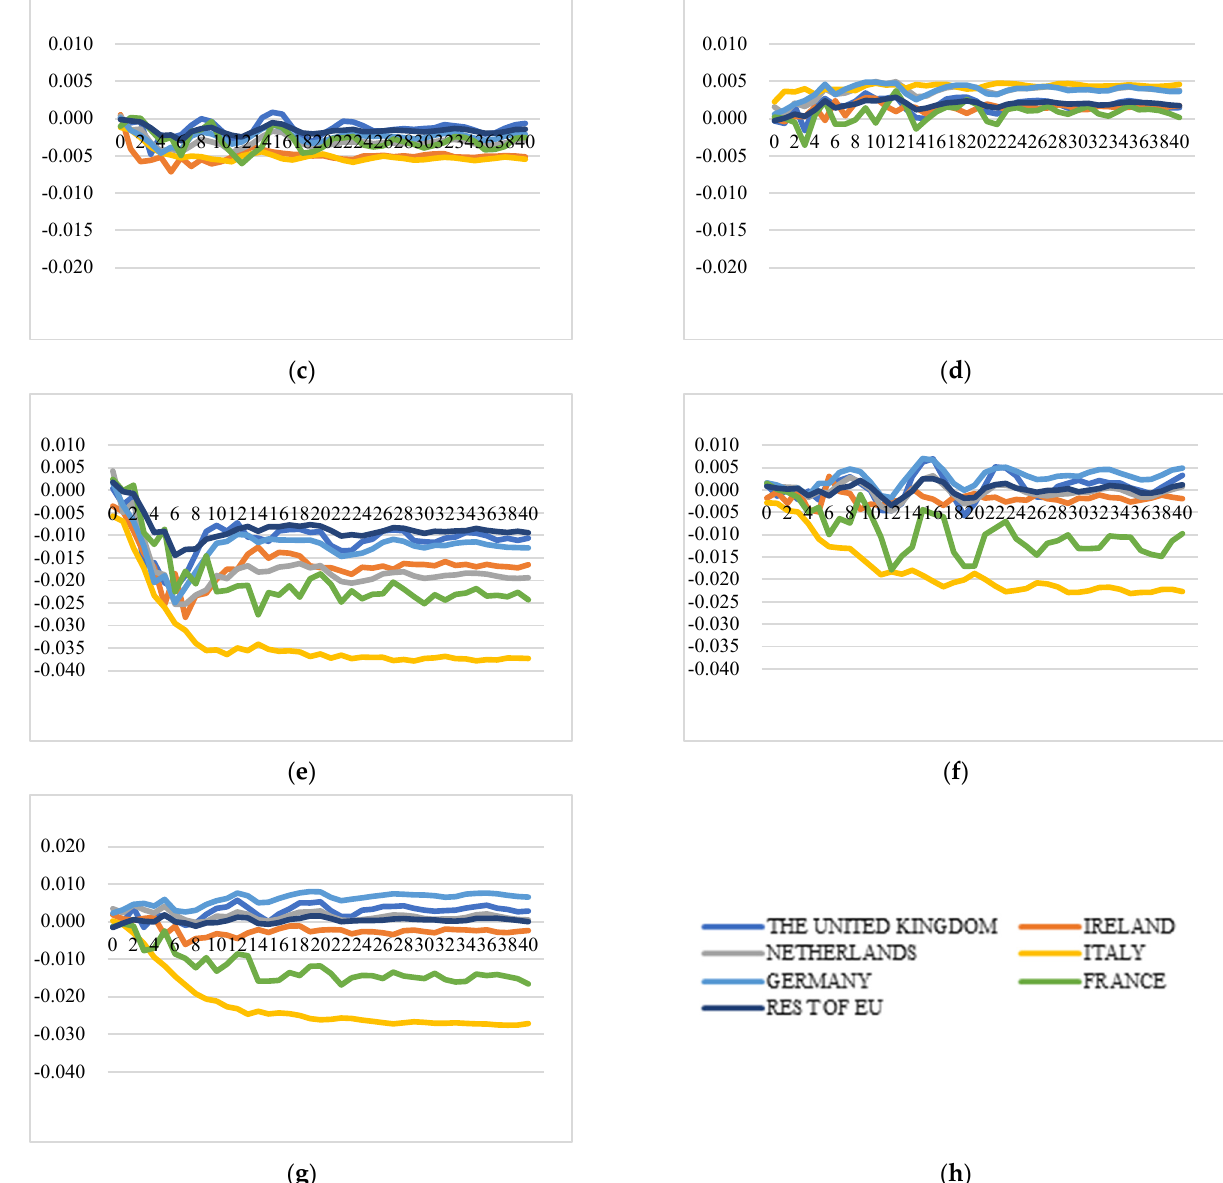
Figure 11. Generalized impulse response functions (GIRFs) of six EU member states’ intra-EU cheese export prices after a positive one-standard-error shock to the Harmonised Index of Consumer Price (HICP) of food (bootstrap median estimates). ( a ) GIRFs after a shock to France’s CPI. ( b ) GIRFs after a shock to Germany’s CPI. ( c ) GIRFs after a shock to Ireland’s CPI. ( d ) GIRFs after a shock to Italy’s CPI. ( e ) GIRFs after a shock to the Netherlands’ CPI. ( f ) GIRFs after a shock to the UK’s CPI. ( g ) GIRFs after a shock to the rest of the EU’s CPI. ( h ) legend.